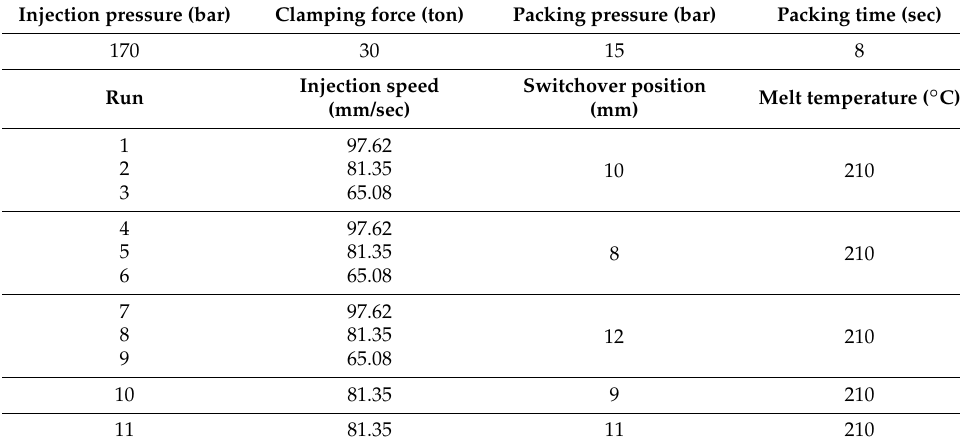
Table 5. Experimental parameters with eight seconds of packing.